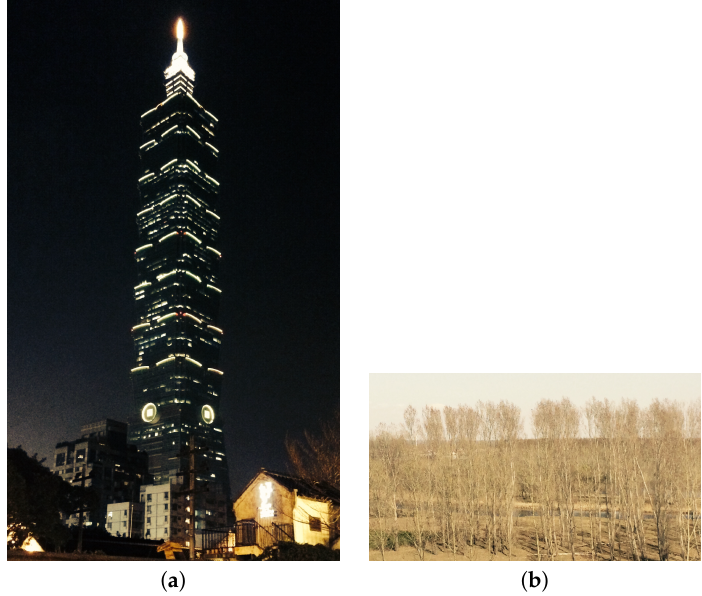
Figure 21. ( a ) An example image with high contrast. ( b ) An image with low